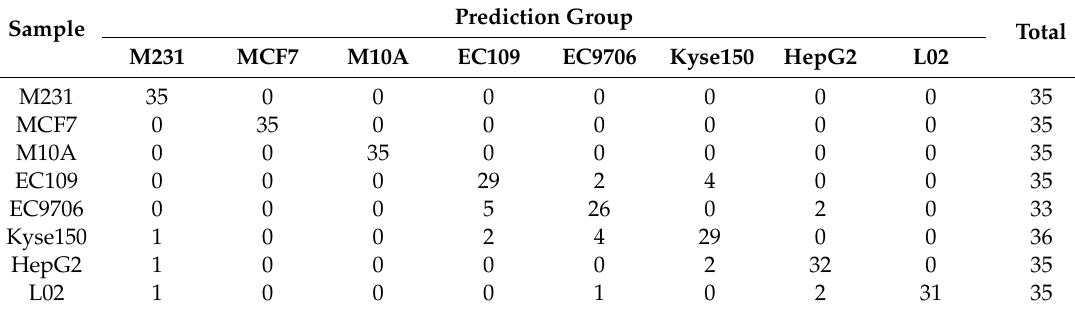
Table 3. PCA-LDA classification of eight di ff erent cell-derived exosomes by the 940–1100 cm − 1 region. Prediction Sample